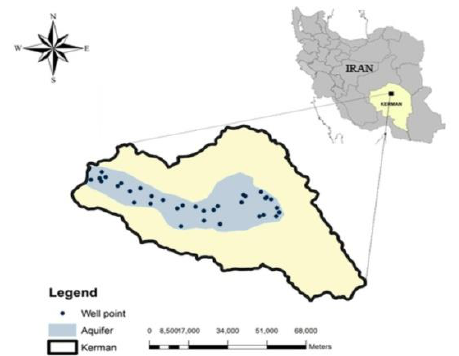
Figure 3.Location of wells in Kerman plain.